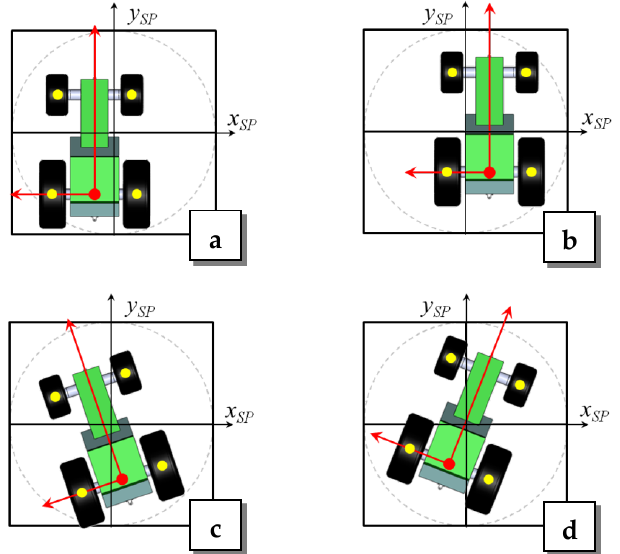
Figure 7. Axial ( a , b ) and angular ( c , d ) misalignments of a tractor frame of reference with respect to the turntable frame of reference. Please note that each of these scenarios will result in the same weight distribution on the quadrants.